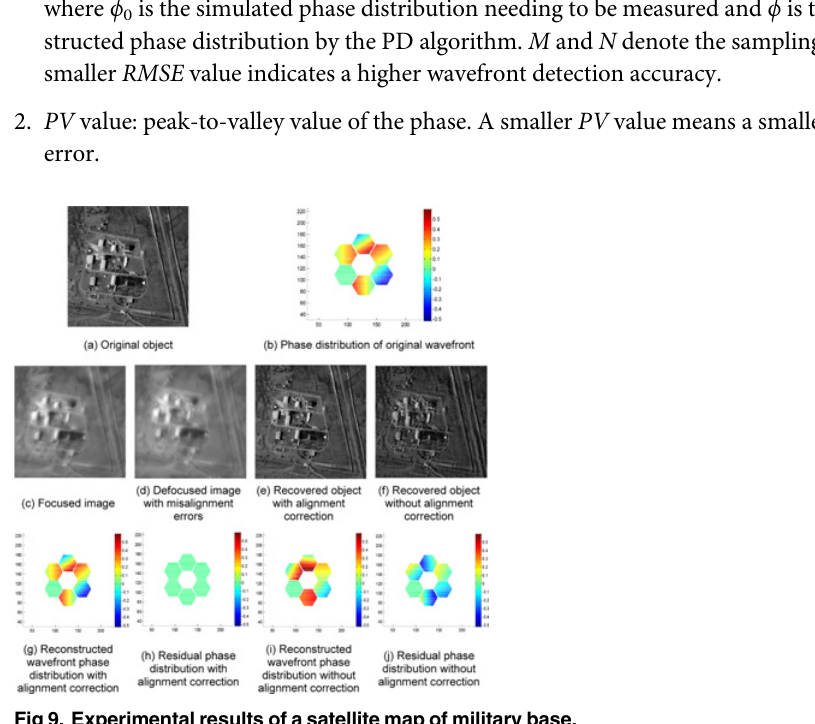
Fig 9. Experimental results of a satellite map of military